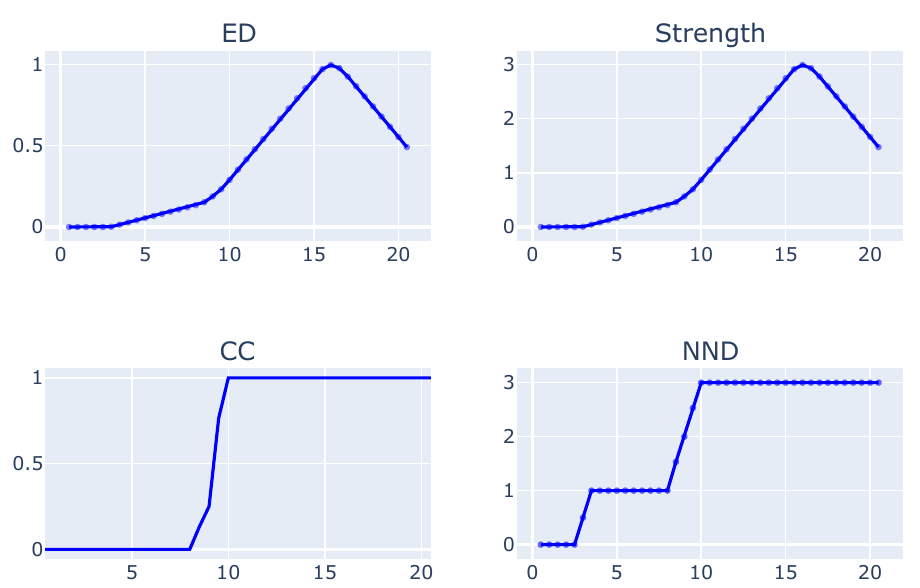
Figure 8. Indicator scores for the example